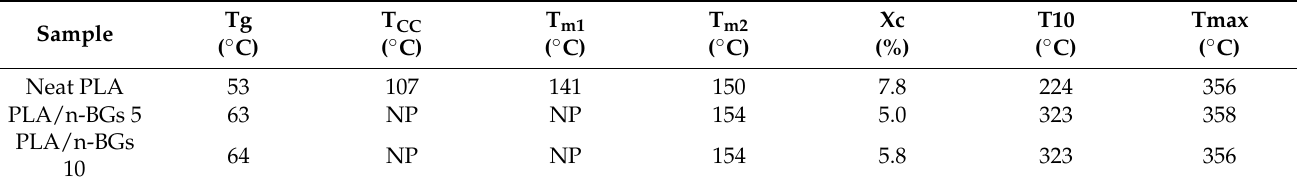
Table 1. Thermal properties of neat PLA, PLA/n-BGs 5 wt.%, and PLA/n-BGs 10